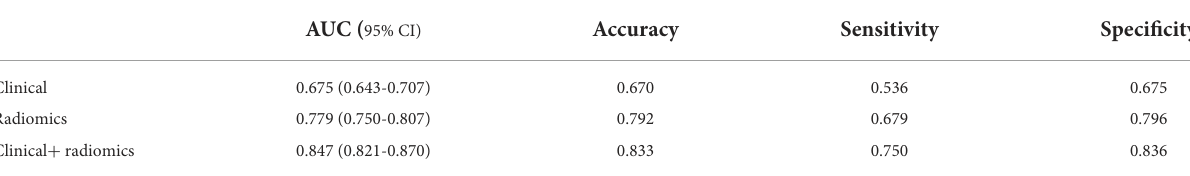
TABLE 3 Performance of two different prediction